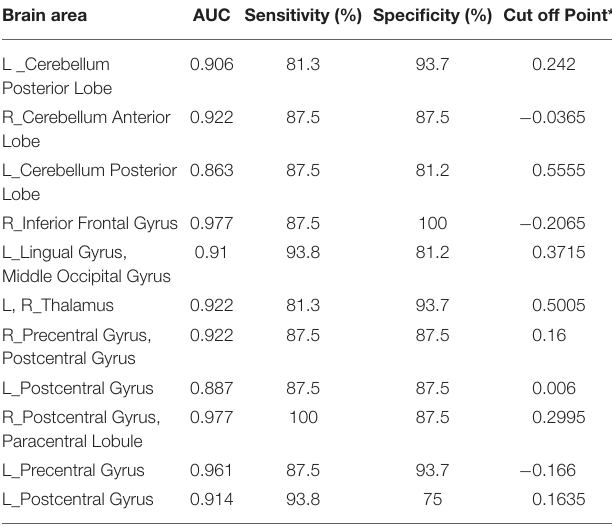
TABLE 3 | ROC curve for the binarized shortFCD differences in brain areas between SD and RW. Brain area